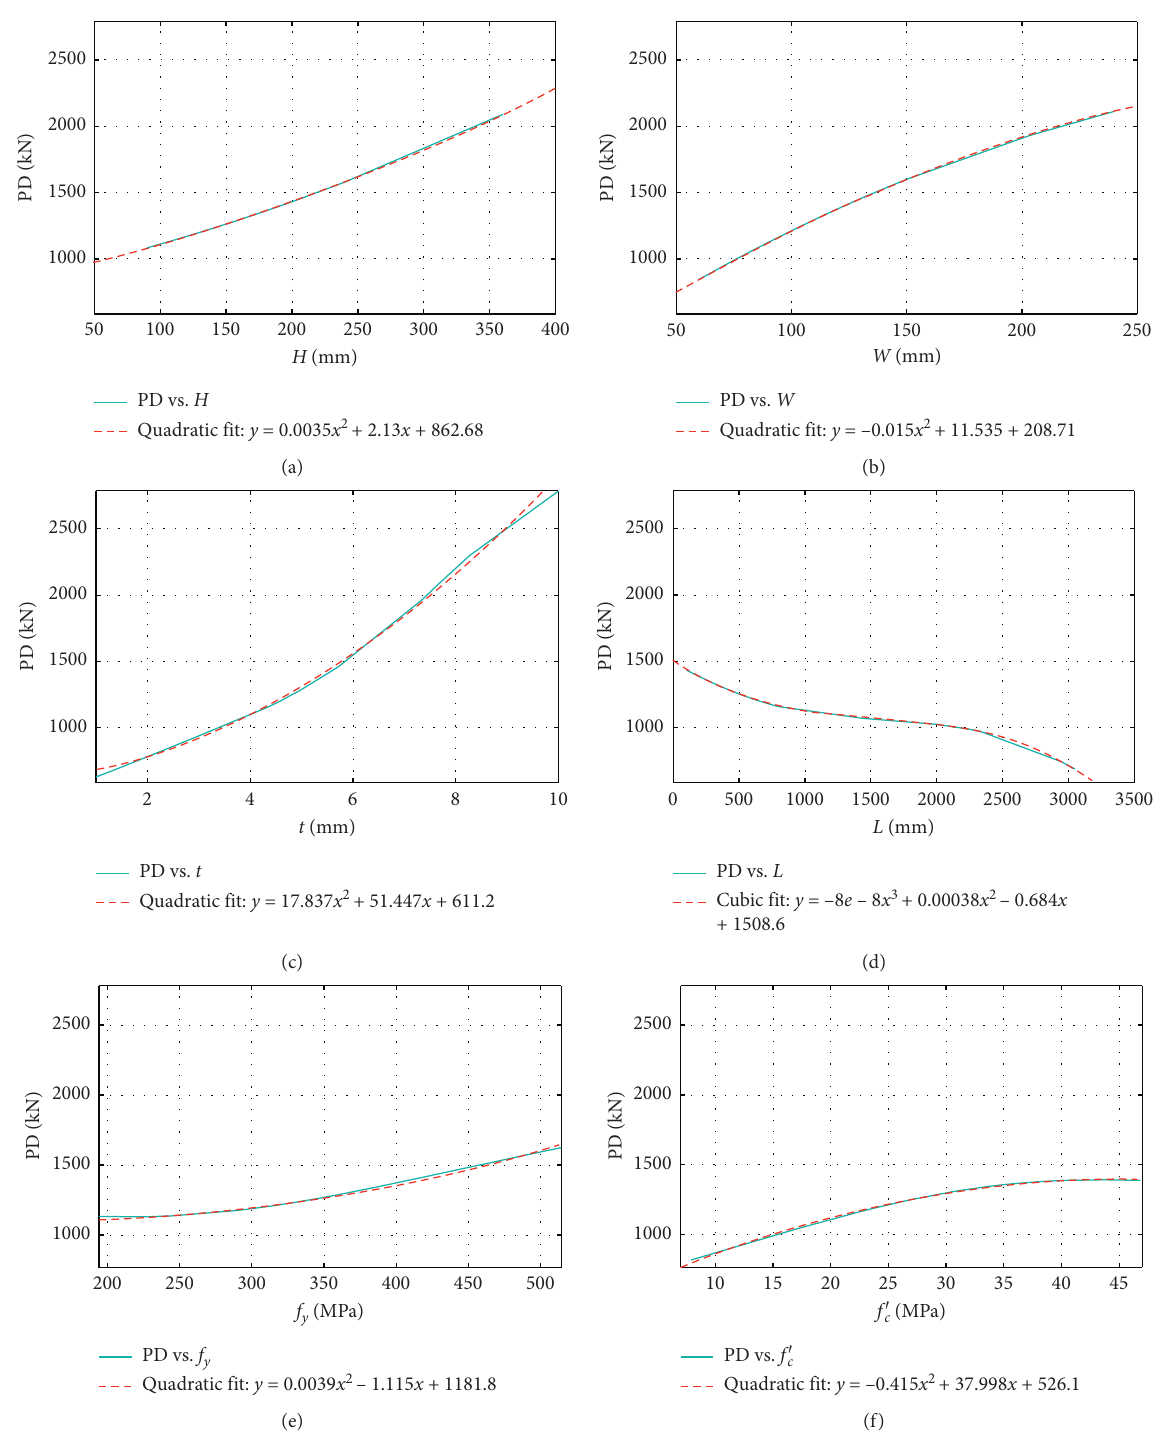
Figure 8: PD analysis for (a) H , (b) W , (c) t , (d) L , (e) f